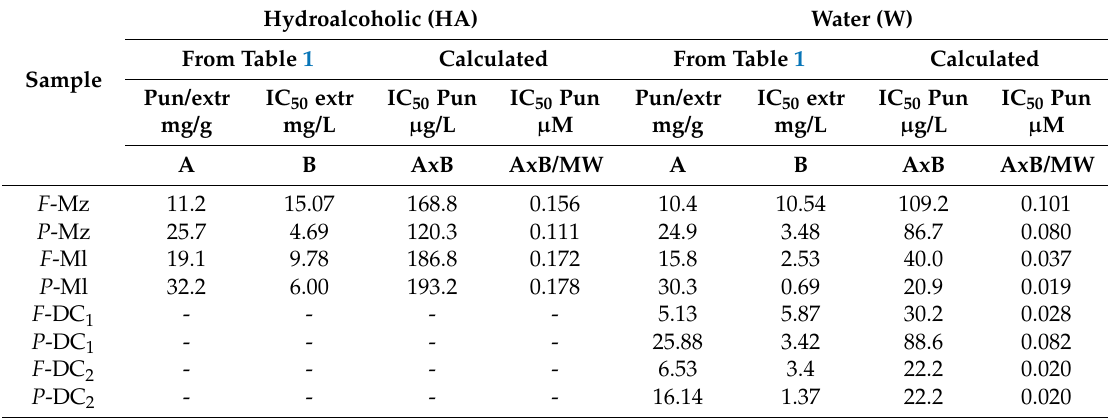
Table 2. Punicalagin relative effects on PDIA3 in hydroalcoholic (HA) and water (W) extracts after